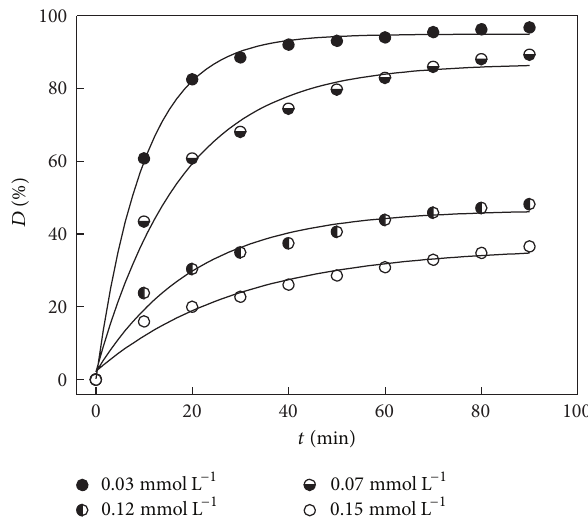
Figure 8: The degradation of RR 195 with different initial con- centrations, experimental conditions: 0.20 g Fe-AO-n-PAN ( 𝑄